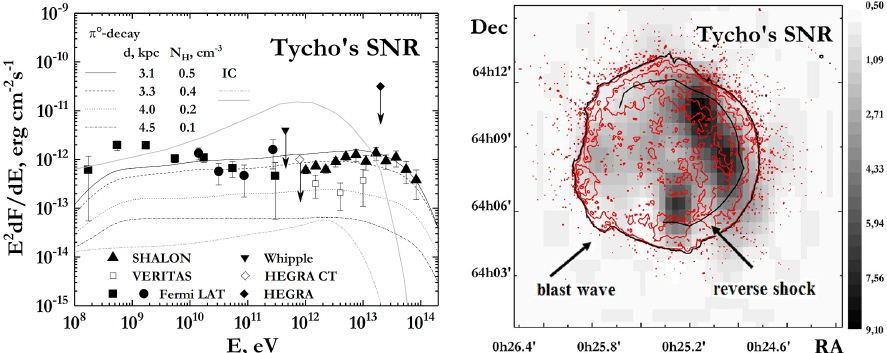
Figure 2. ( left ): Spectral energy distribution of Tycho’s SNR: (cid:78) at TeV energies show the data from SHALON observations. ( right ): Emission map of SNR by SHALON (grey scale). Red lines show the X-ray emission by Chandra (see text for the